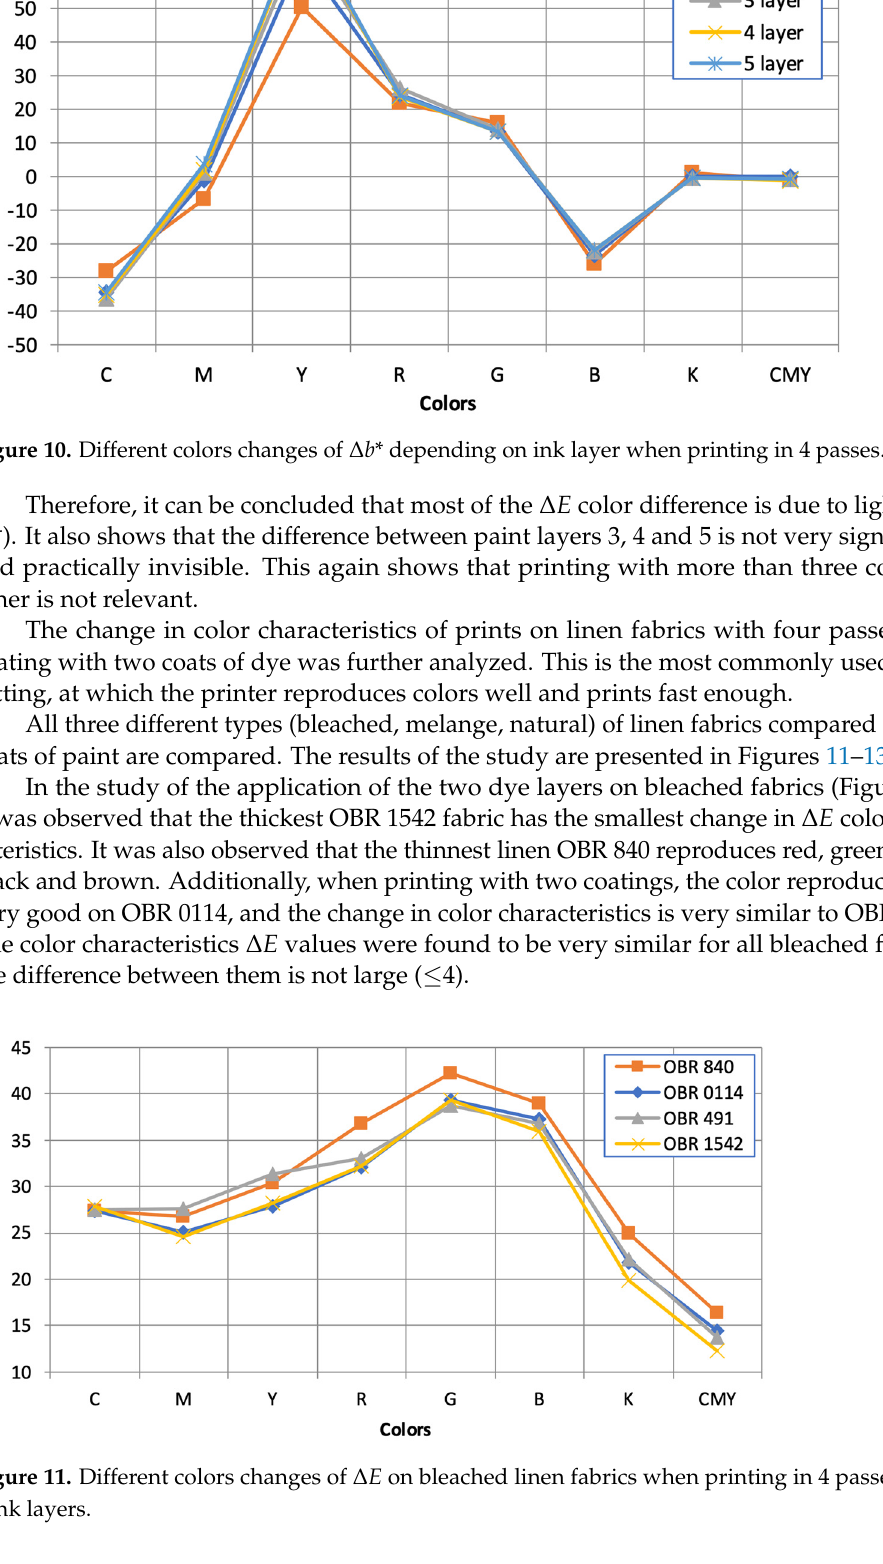
Figure 9. Different colors changes of Δ a * value depending on ink layer when printing in 4 passes.